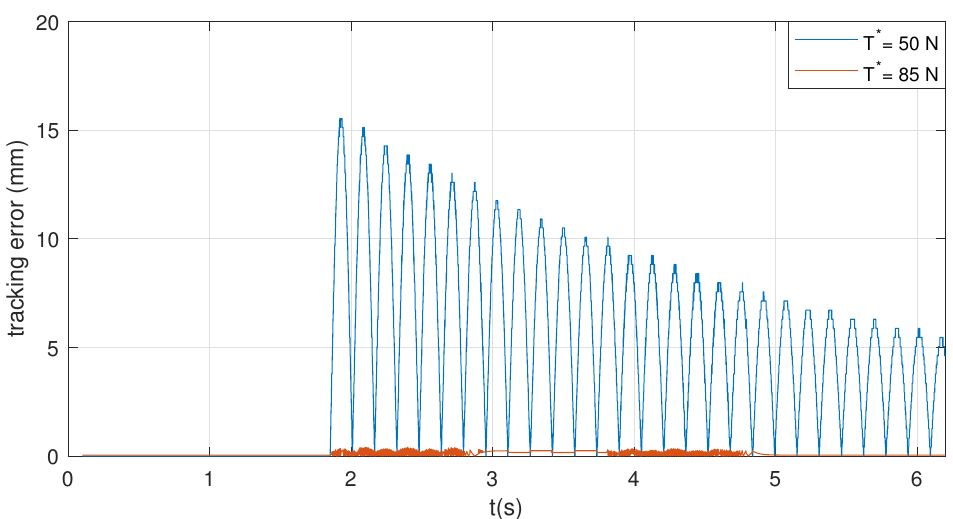
Figure 16. Tracking error of horizontal manoeuvres with different values of T ∗